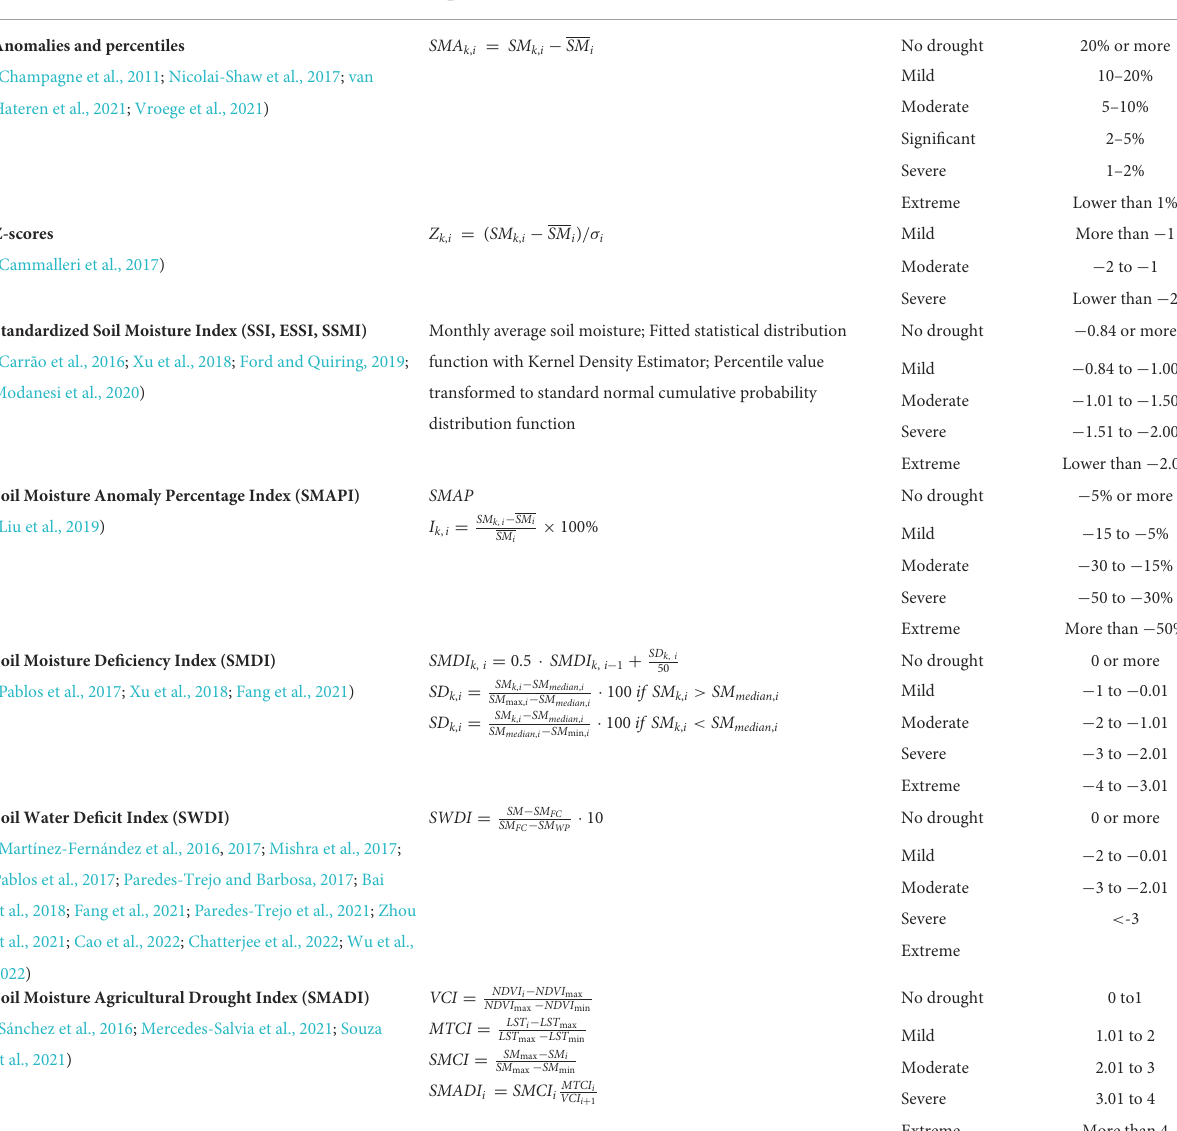
TABLE 2 Drought indicators based on SM